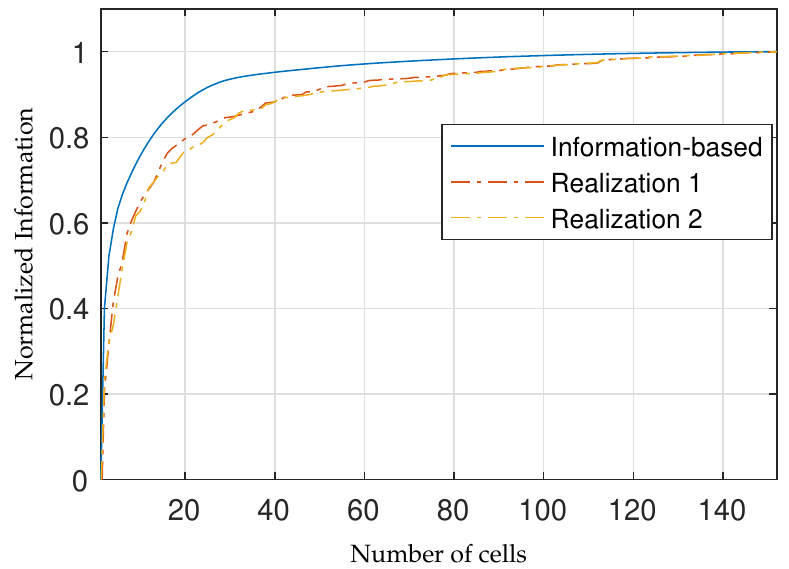
Figure 8. Normalized logarithm of D-optimality when optimal selection is done compared to Figure 8. Normalised logarithm of D-optimality when optimal selection was done compared to random realizations random